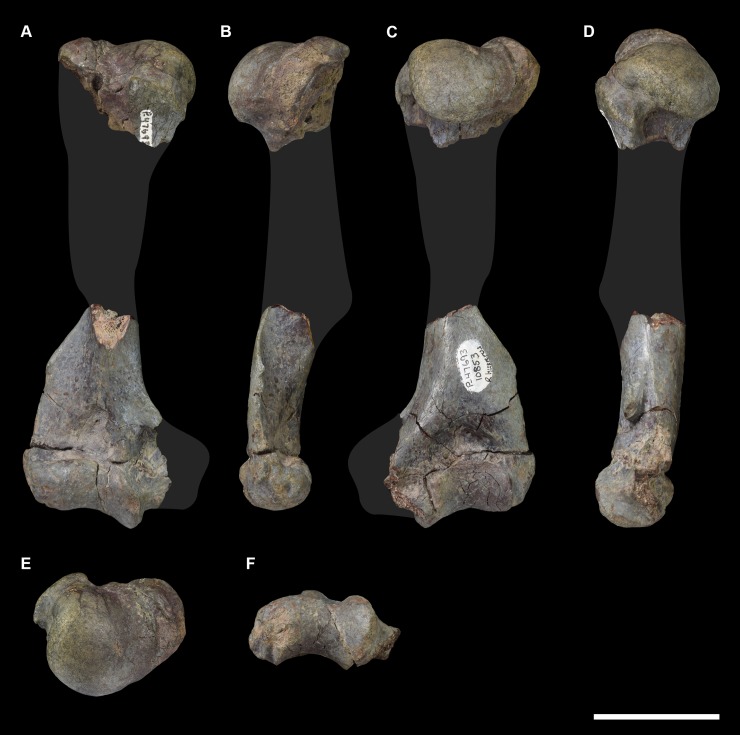
Right humerus of Periptychus carinidens (NMMNH P-47693).(A) anterior view; (B) lateral view; (C) posterior view; (D) medial view; (E) proximal view, (F) distal view. Scale bar: 30mm.